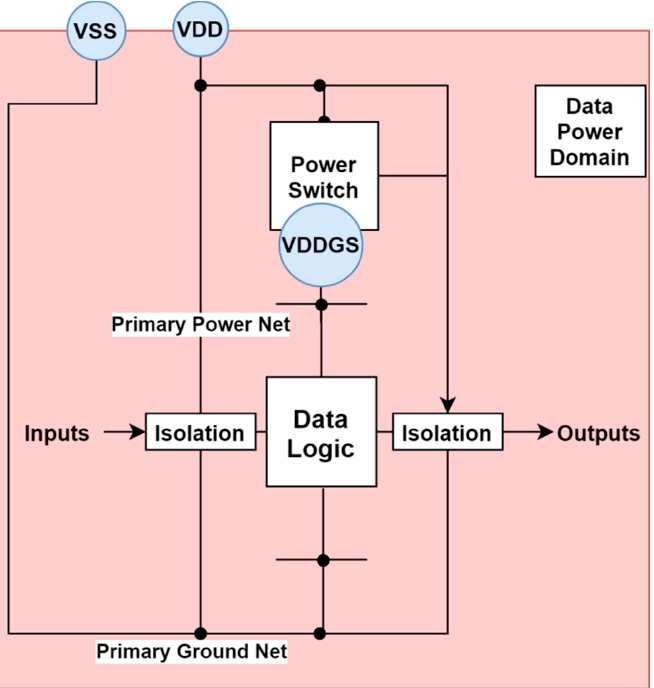
Figure 12. The block diagram highlighting the power domain of the data subrouter with power gating implementation.